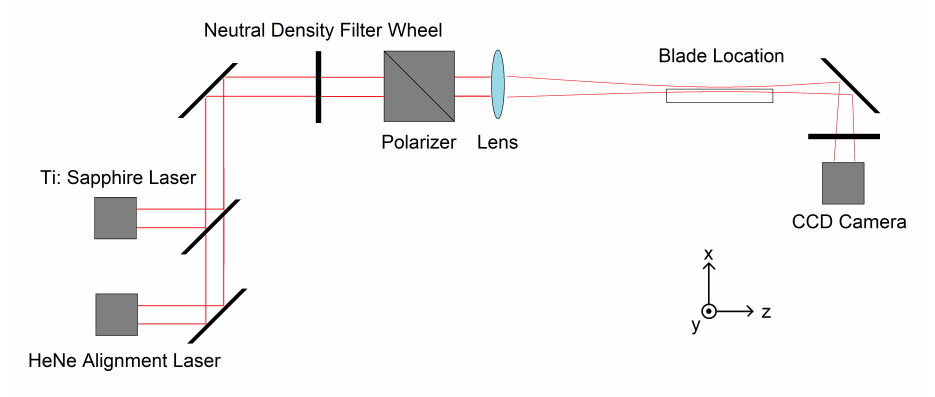
Figure 4. General optics table geometry involved in nano-blade illumination experiments before adding electron